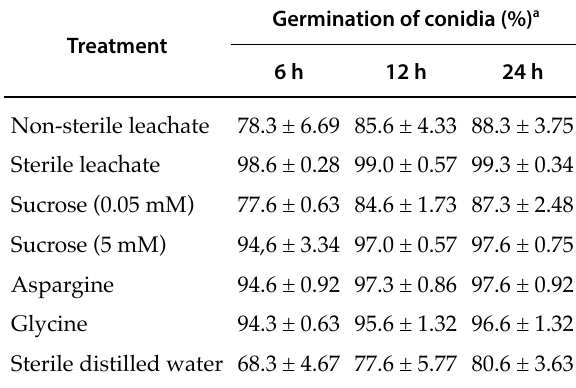
Table 2. Results of Experiment 1a (Table 1). Mean propor - tions of germinated Colletotrichum godetiae conidia in non- sterile olive leachate, sterile olive leachate, in solutions containing three different nutrient elements, and sterile distilled water (control), after 6, 12 and 24 h of